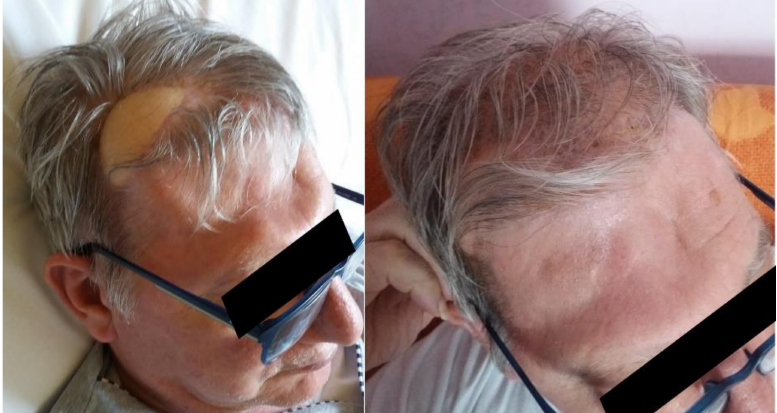
Figure 8. Facial appearance of the patient after surgery. The skin paddle is still recognizable, although easily covered by the hair of the